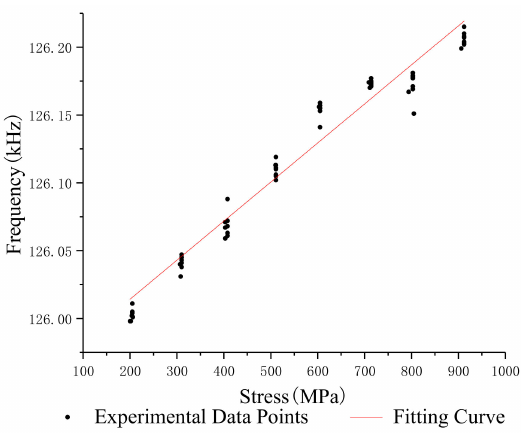
Figure 9. Stress-frequency curve—5 m.